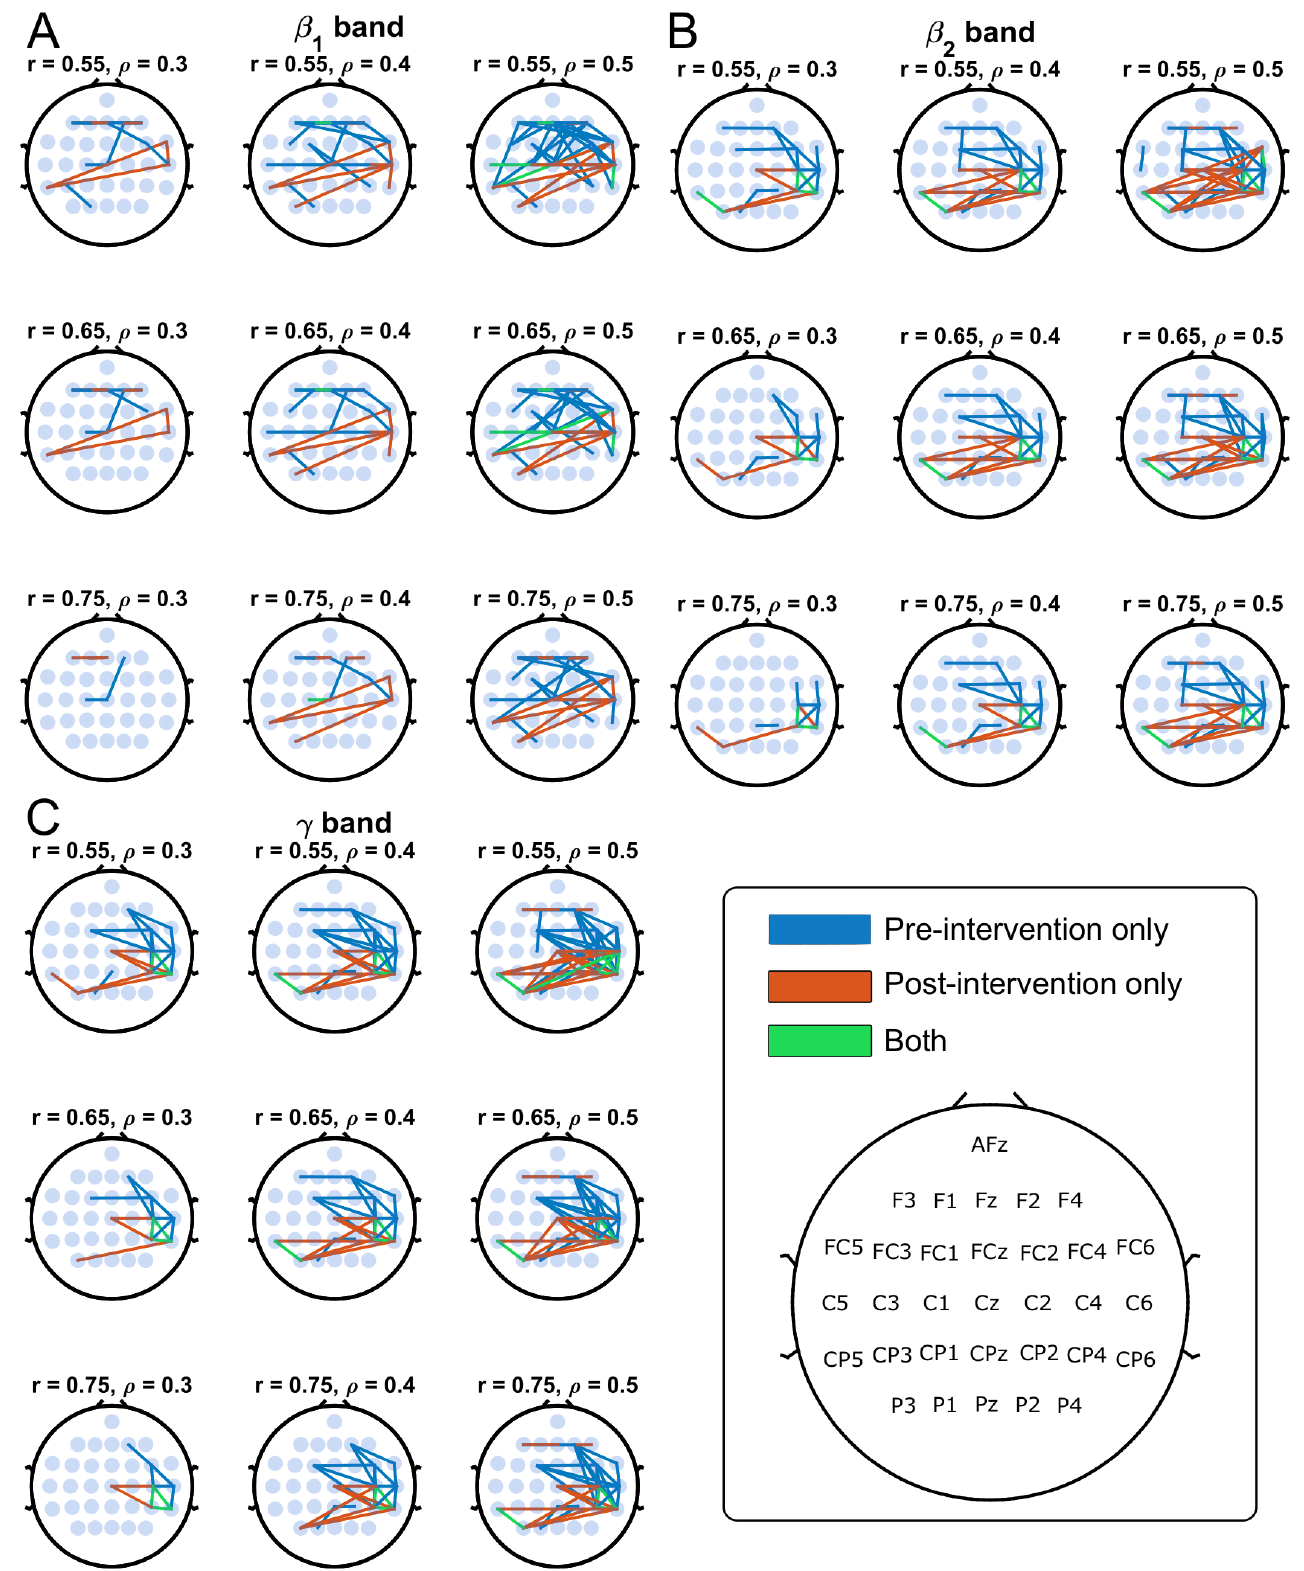
Figure 4. Functional connections in the group’s adjacency matrix for all threshold values under study. Blue, red and green edges indicate functional connections that were present only during the first RS-recording, the second RS-recording, and both, respectively. Plots are shown for the β 1 ( A ), β 2 ( B ) and γ ( C ) frequency